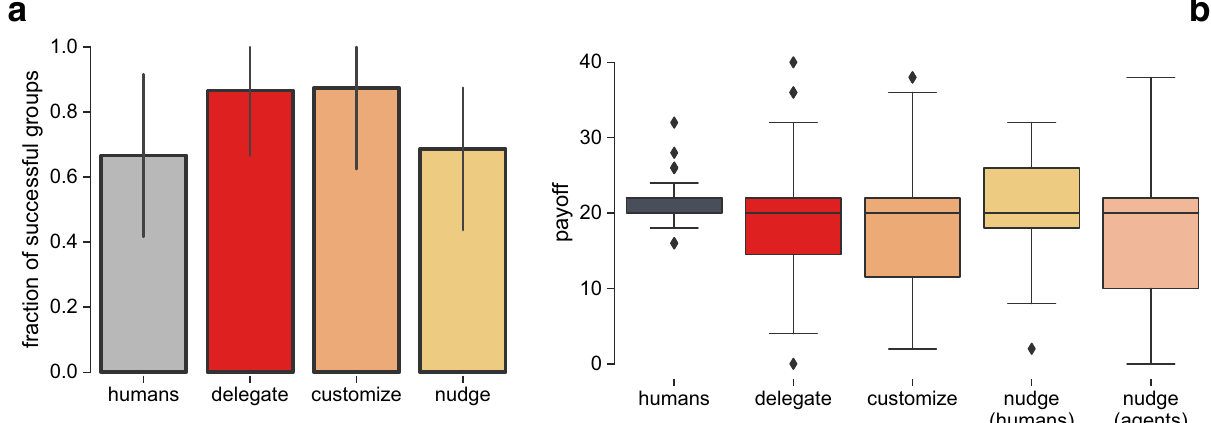
Figure 1. Group achievement and average payoff. Panel ( a ) compares the fraction of successful groups observed in the humans control treatment (black: n = 12 , 66.7% ) to the results of the delegate (red: n = 15 ), customize (orange: n = 8 ) and nudge (yellow: n = 16 ) treatments. There is an increase in groups that achieve the target on the delegate ( 87% ) and customize ( 87.5% ) treatments, however this trend is not maintained in the nudge treatment ( 68.8% ). Panel ( b ) shows the distribution of payoffs obtained by participants of the four treatments. The results indicate that the variance of payoffs increases in all treatments with delegation of hybrid